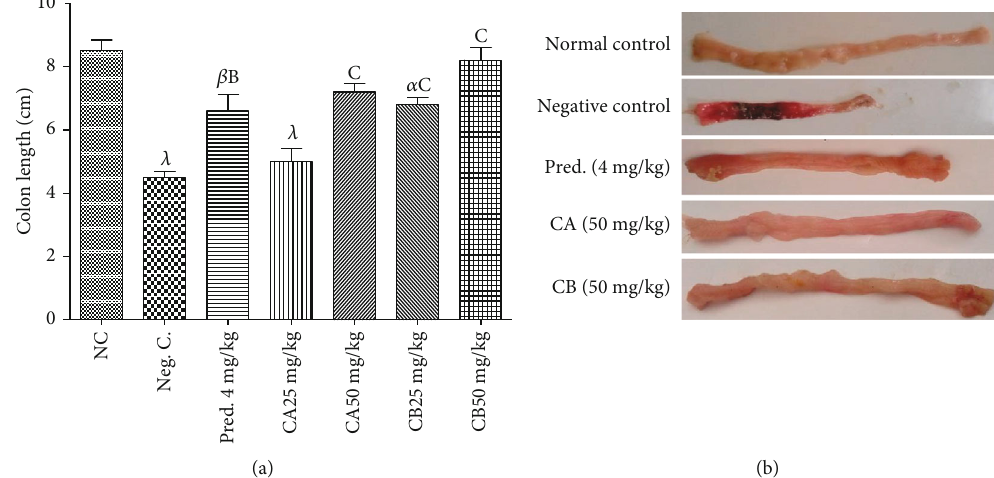
Figure 3: E ff ect of Combretin A and Combretin B on colon length in DSS-induced colitis in rats. Mice colons were isolated 10 days after DSS administration, and their lengths were measured. Values are expressed as mean ± SEM for six animals and analyses by one-way ANOVA followed by Tukey post hoc test; B p < 0 : 01 , C p < 0 : 001 : signi fi cant di ff erence compared with negative control (Neg. C); α p < 0 : 05 , β p < 0 : 01 , λ p < 0 : 001 : signi fi cant di ff erence compared with normal control (NC). CA: Combretin A; CB: Combretin B.